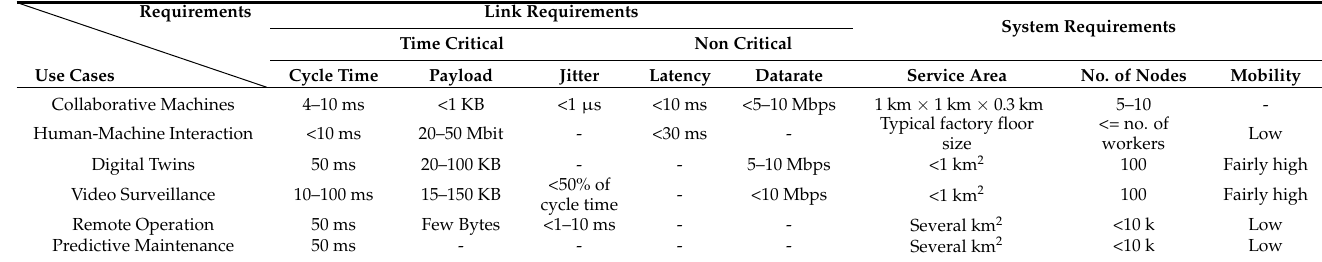
Table 1. Use cases for smart manufacturing along with their requirements [42].